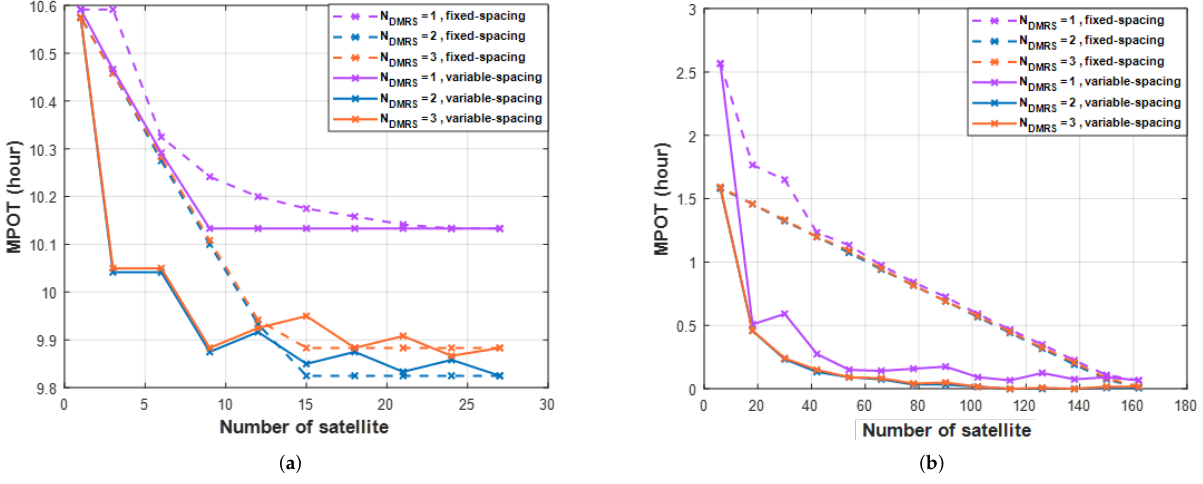
Figure 17. The maximum persistent outage time ( MPOT ) for different numbers of DMRS symbols per slot. ( a) one orbit, ( b ) six orbits.